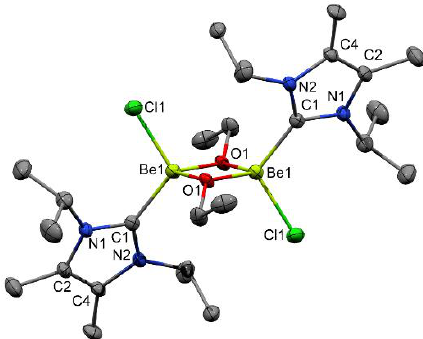
Figure 3. Molecular structure of 3 (thermal ellipsoids at 50% probability; H atoms omitted for clarity). Selected bond distances (Å) and angles (deg): Be1 − O1: 1.621(4); Be1 − O1: 1.641(4); Be1 − C1: 1.855(4); Be1 − Cl1: 2.044(3); N1 − C1: 1.362(3); N1 − C2: 1.391(3); 1.362(3); N2 − C4: 1.393(3); C2 − C4: 1.355(4). O1 − Be1 − O1: 89.99(18); O1 − Be1 − C1: 113.9(2); O1 − Be1 − C1: 119.0(2); C1 − Be1 − Cl1: 109.11(18).